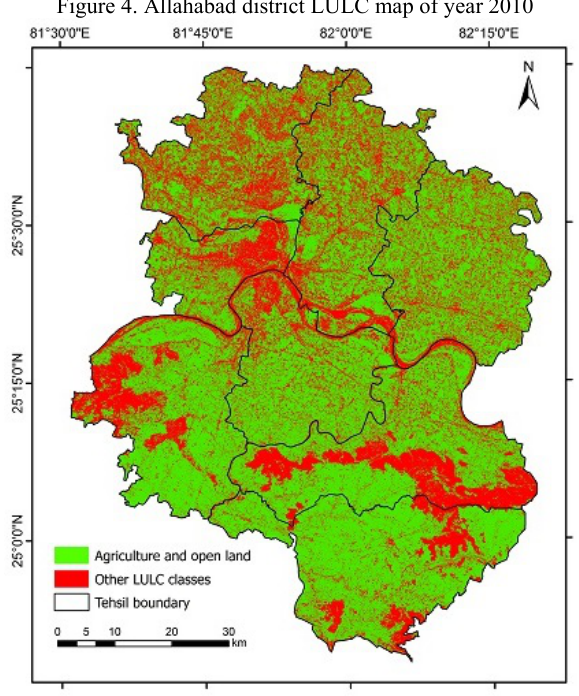
Figure 5. Allahabad district LULC map of year 2018